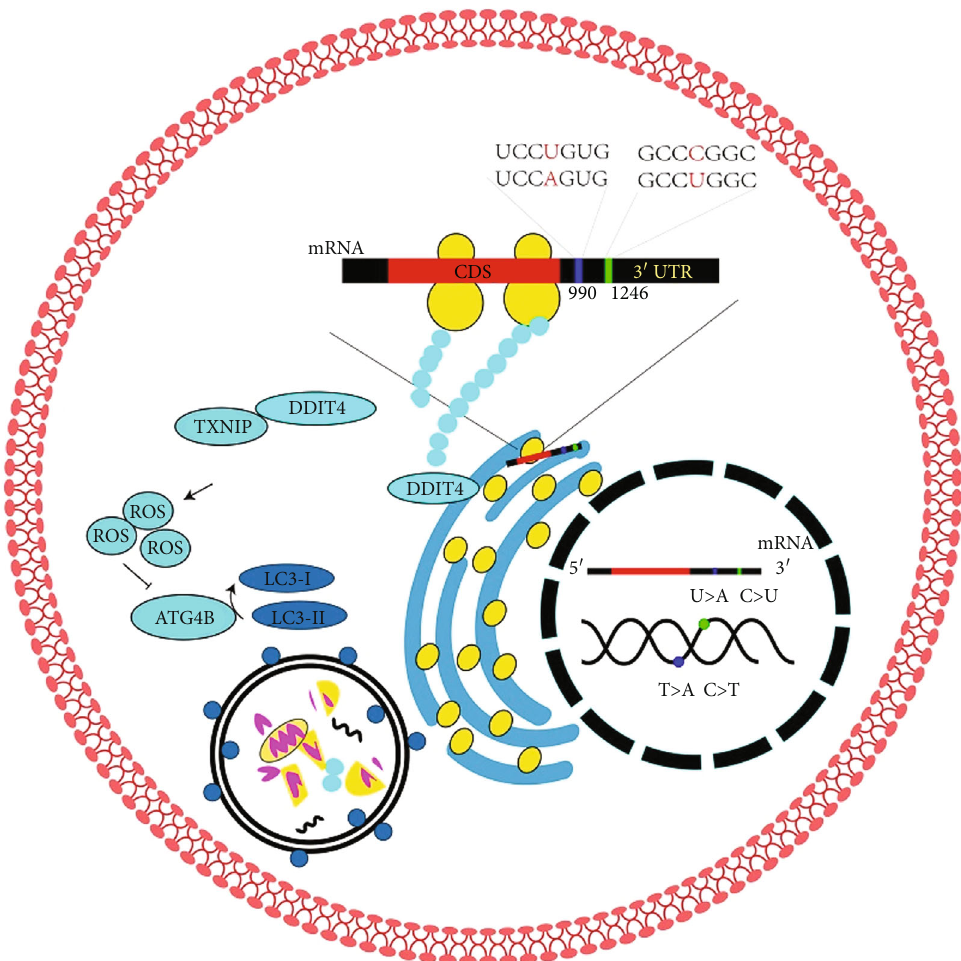
Figure 4: Hypothetical image of DDIT4 mRNA mutation in pancreatic